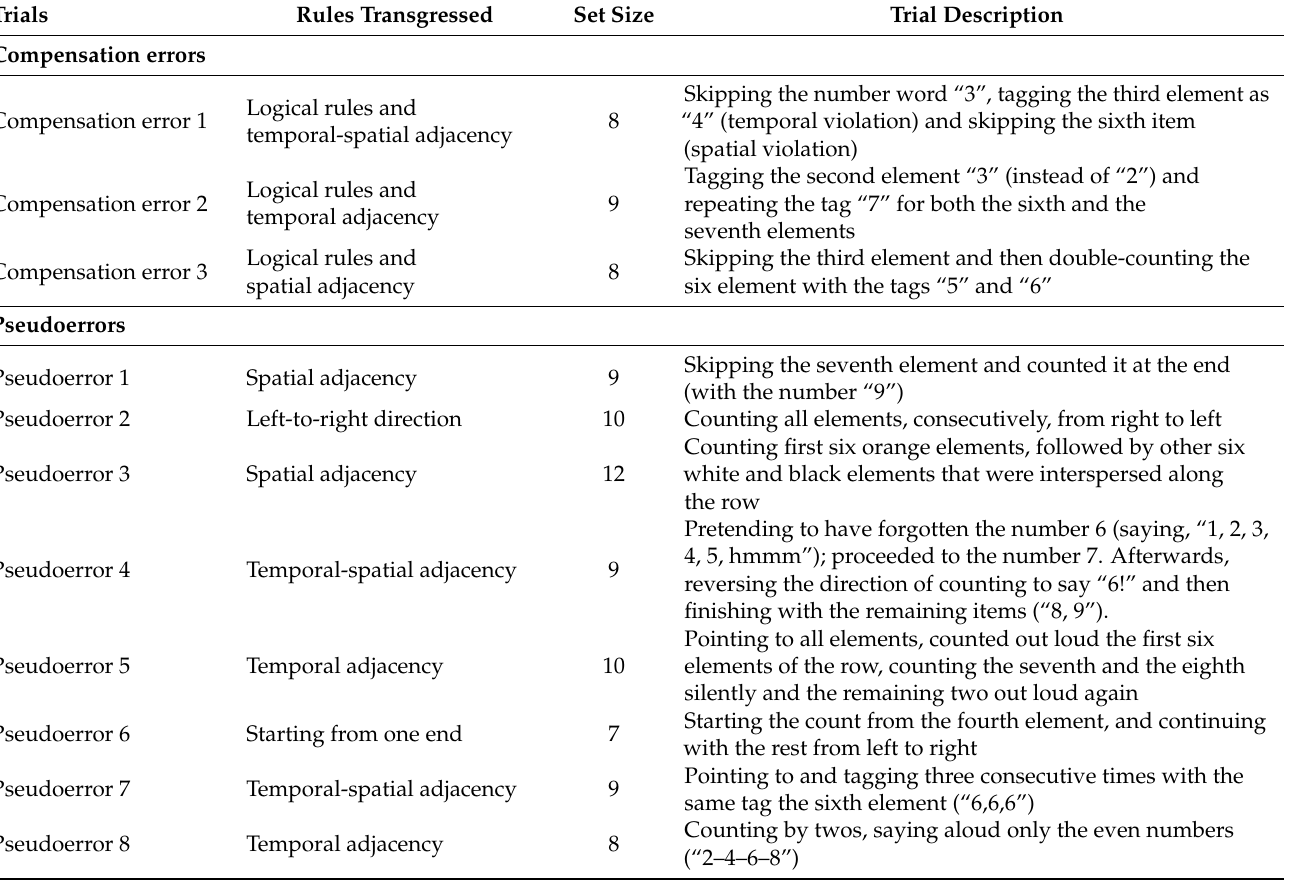
Table 1. Description of the non-routine counting